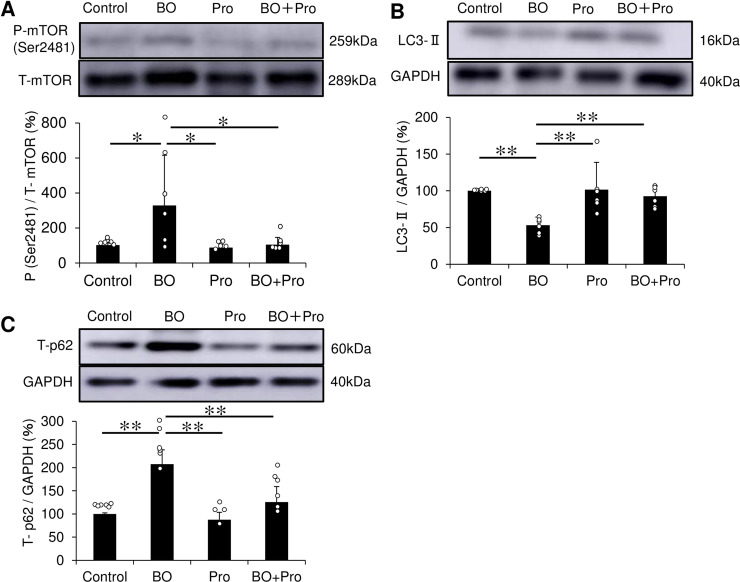
Effects of BO on mTORC2 phosphorylation, LC3 and p62 expression in cardiac muscle.(A) mTOR phosphorylation at Ser 2481, a specific marker of mTORC2 formation, was significantly increased in the BO group, but this increase was blocked in the BO + Pro group. *P < 0.05 by one-way ANOVA followed by the Tukey-Kramer post hoc test (S10A Fig of S1 Data). (B) Expression of LC3-II, an autophagosome marker, was significantly decreased in the BO group, but this decrease was blocked in the BO + Pro group. **P < 0.01 by one-way ANOVA followed by Tukey-Kramer post hoc test (S10B Fig of S1 Data). (C) p62 expression, which correlates inversely with autophagic degradative activity, i.e., autophagic flux, was significantly increased in the BO group, but this increase was blocked in the BO + Pro group. **P < 0.01 by one-way ANOVA followed by the Tukey-Kramer post hoc test (S10C Fig of S1 Data). Data show means ± SD and scattered dots show individual data. Full-size images of immunoblots are presented in S1 Data of supporting information.